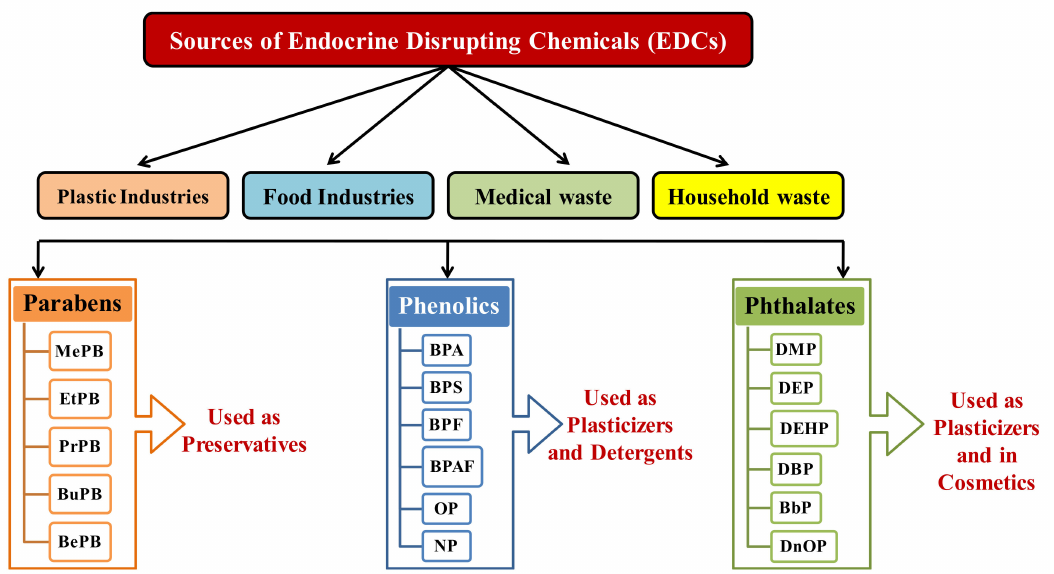
Figure 3. Types and sources of